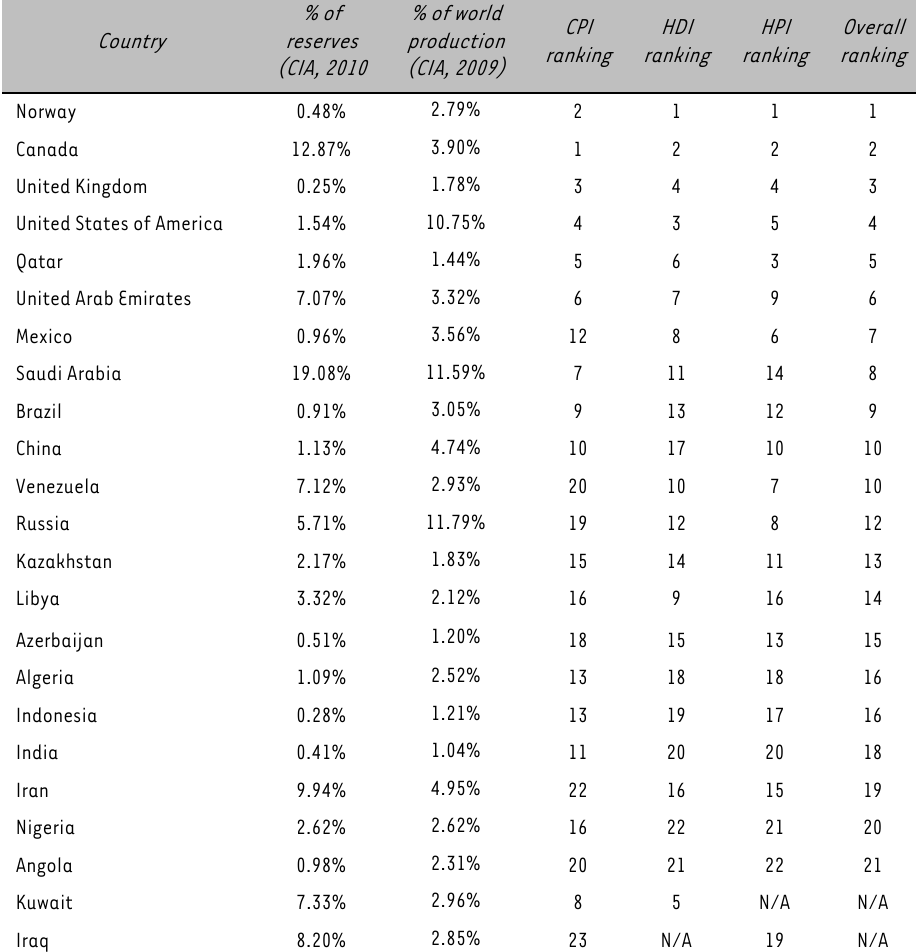
TABLE 1: Ranking of the selected oil-producing countries relative to each other based on the HDI, HPI and CPI Country